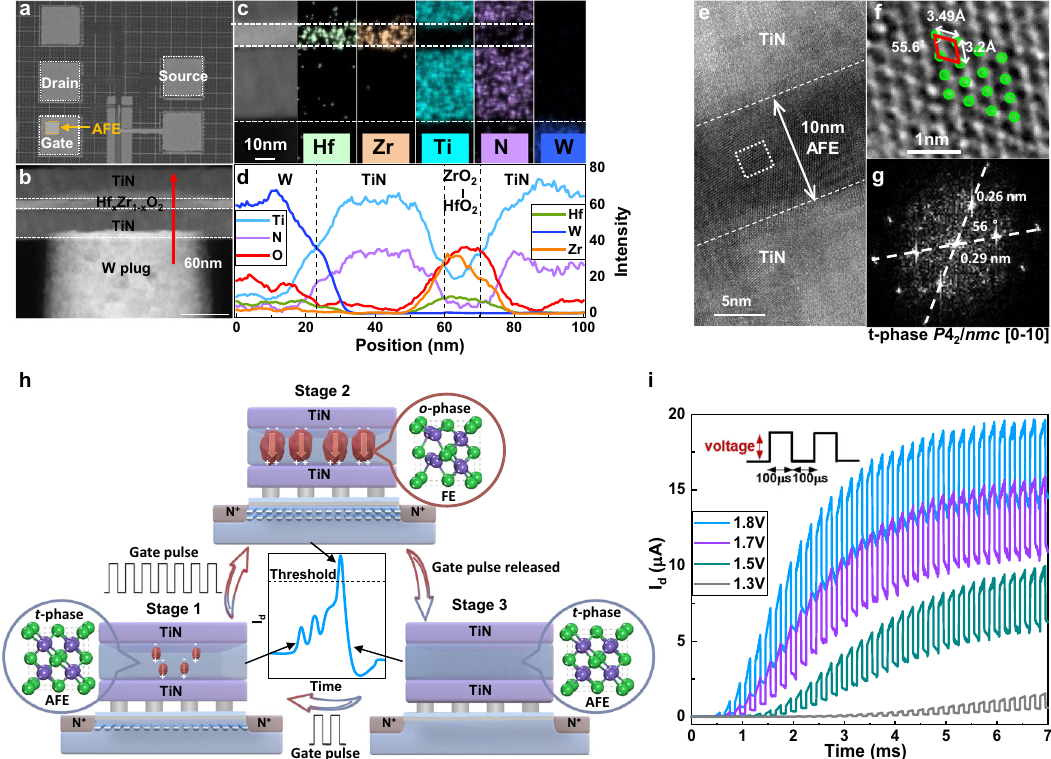
Fig. 2 | Device characteristics and mechanism of AFeFET neurons. a Planer structure of AFeFET device. b The cross-sectional image of AFeFET device. c The elemental mapping of the materials in the system for Hf, Zr, Ti, N, and W, respec- tively. d ThelinescanEDSofthedevicecross-section,whichcorrespondstothered arrow in ( b ). e The HRTEM image of the AFE fi lms. f The crystal structure of the domain, whichcorresponds to the white squarearea in( e ). g The FFT image ofthe crystalline domain in ( f ). The measured angles and distances between relative crystal faces, and diffraction spots suggest the existence of [0-10] oriented tetra- gonal P 4 2 /nmc structure. h The integrate-and- fi re dynamics of AFeFET neuron. At